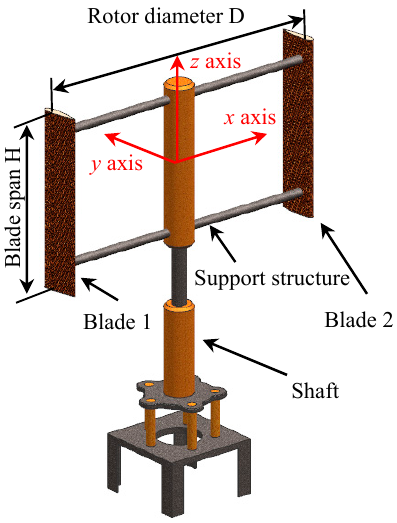
Figure 1. Geometric model of straight-bladed VAWT in CFD simulations and wind tunnel experiments.